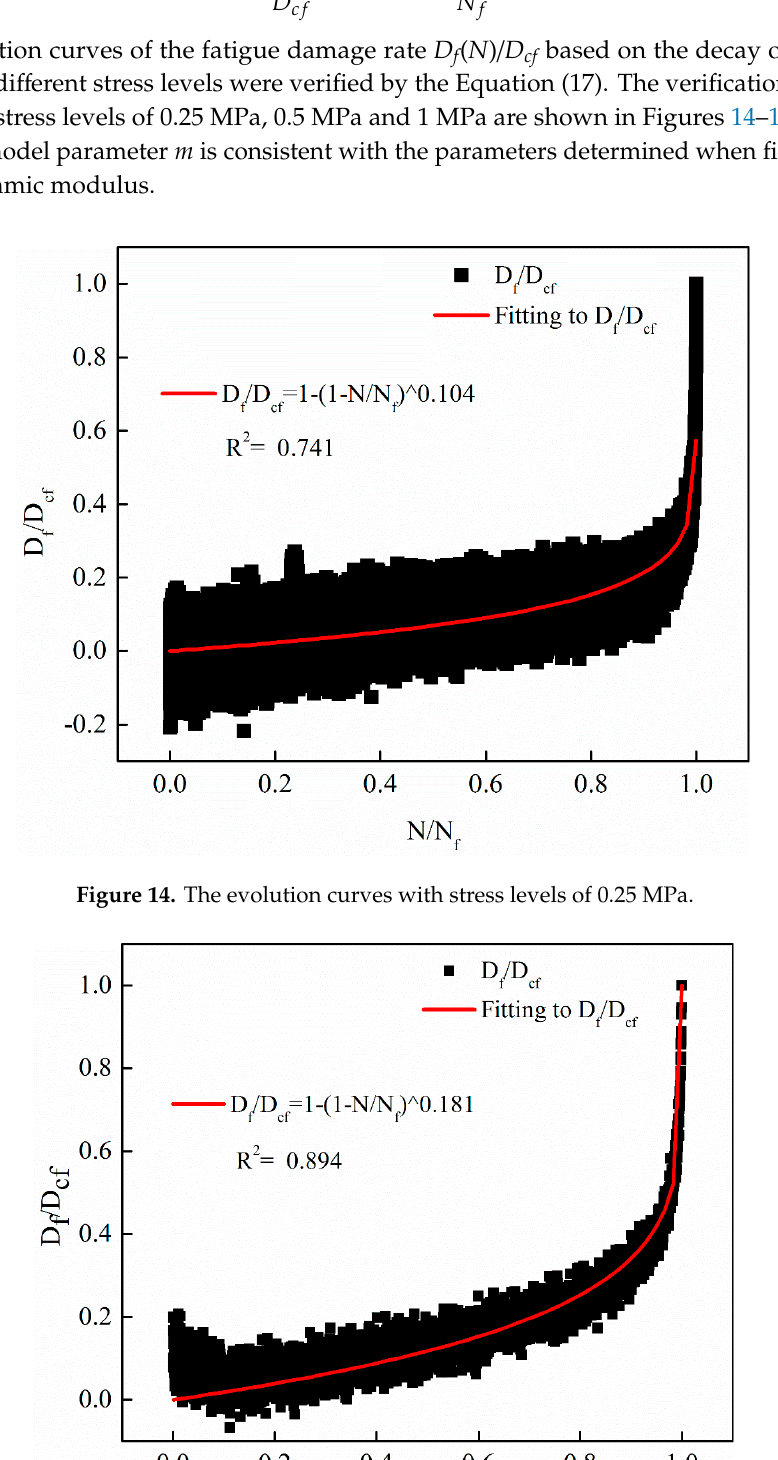
Figure 16. The evolution curves with stress levels of 1 MPa. From Figures 14–16, it can be observed that the proposed non-linear fatigue damage model is in good agreement with the original fatigue test data. The fatigue damage has prominent non-linear characteristics with the change of cycle ratio, which reveals the evolution law of non-linear fatigue damage of asphalt mixture. By substituting Equation (7) and Equation (14) into Equation (16), the nonlinear fatigue damage evolution Equation (18) is obtained.